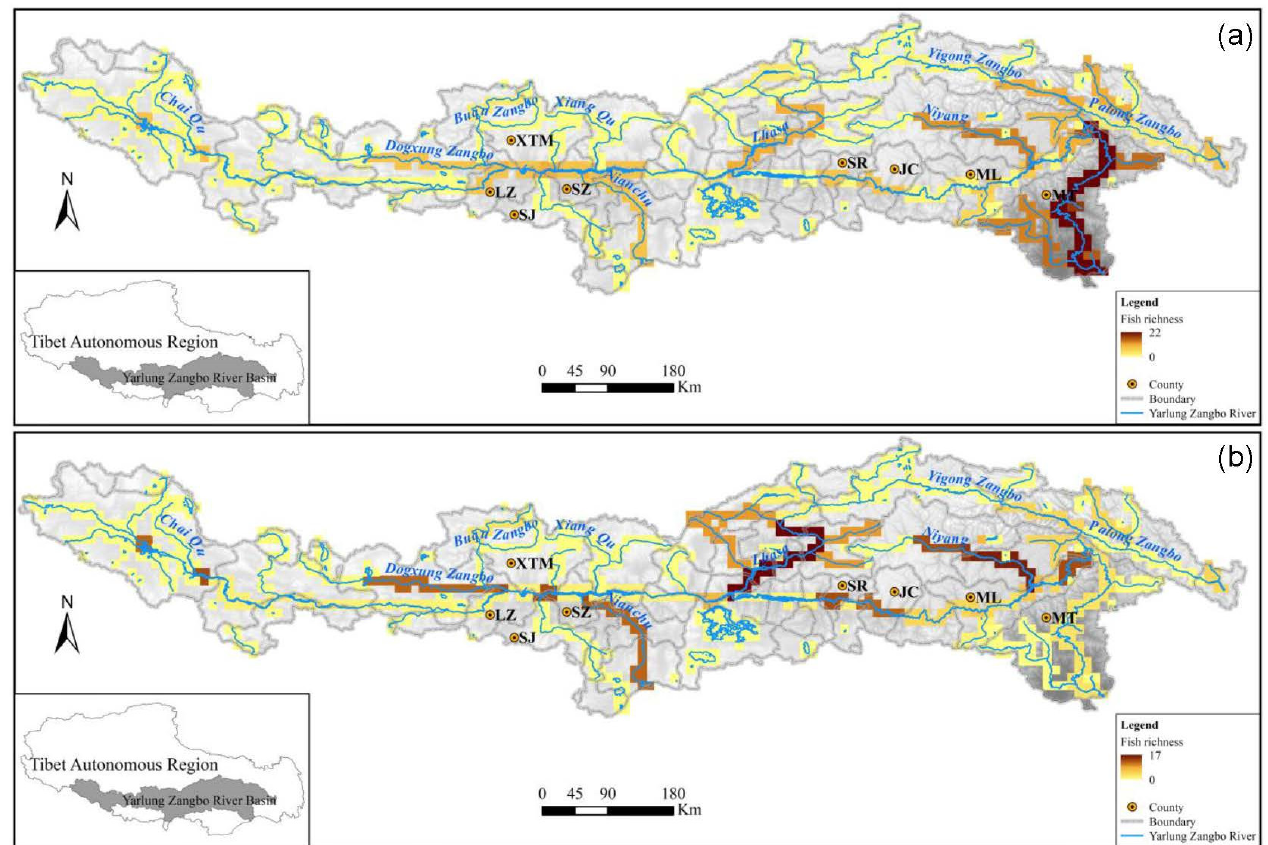
Figure 2. ( a ) Native fish richness distribution in the Yarlung Zangbo River Basin. ( b ) Non-native fish richness in the Yarlung Zangbo River Basin. The references “Fishes of Qinghai-Tibet Plateau” [25] and “Tibet Aquatic Biological Conservation Series 1–3” [29–31] were used to categorize the “native fish” and “non-native fish” species in this study. County Codes: XTM, Xietongmen; LZ, Lazi; SJ, Sajia; SZ, Sangzhu; SR, Sangri; JC, Jiacha; ML, Milin; MT, Moetro. The native fish richness distribution map (Figure 2a) shows the highest fish richness (22 species) fluvial systems in the section of the Yarlung Zangbo River within Motero County. Interestingly, the Yarlung Zangbo River midstream and downstream transition areas, which are the highest native fish richness regions, included the Niyang River, Palong Zangbo River, Yigong Zangbo River and Yarlung Zangbo River (section of Motero). Meanwhile, the other fluvial streams that had high fish richness corresponded to the Yarlung Zangbo River midstream, including the Dogxung Zangbo River (6 species), Nianchu River (6 species) and Lhasa River (8 species). In contrast, fish richness was low in the upstream region, with the highest fish richness in the fluvial system, with only 7 fish. The cluster analysis for native fish based on the fluvial system (Figure 3), with 23 tributaries consisted of three discrete parts, located upstream (one part) and midstream (two parts),